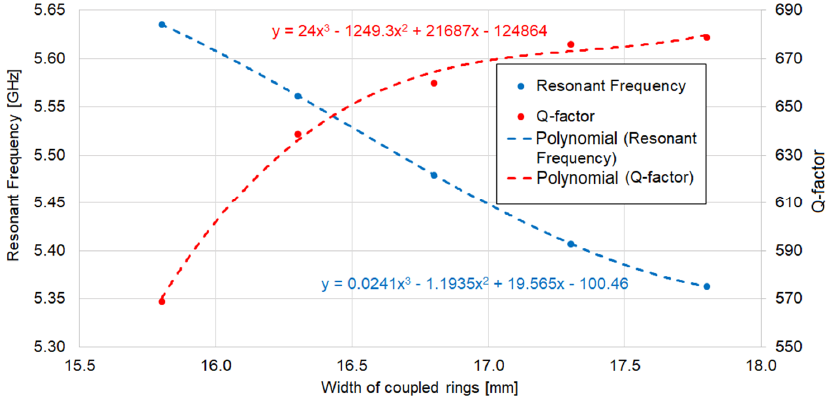
Figure 3. Influence of the coupled rings width on the resonant frequency and Q-factor.